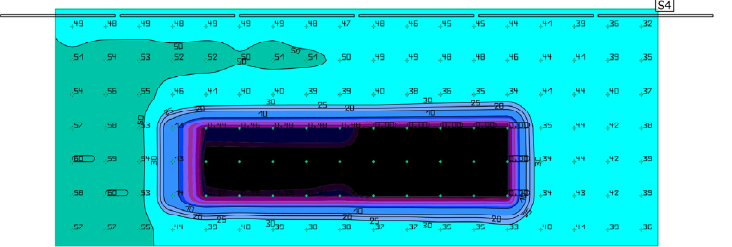
Figure 16. Illuminance distribution on the screen/blackboard by asymmetric distribution LED light